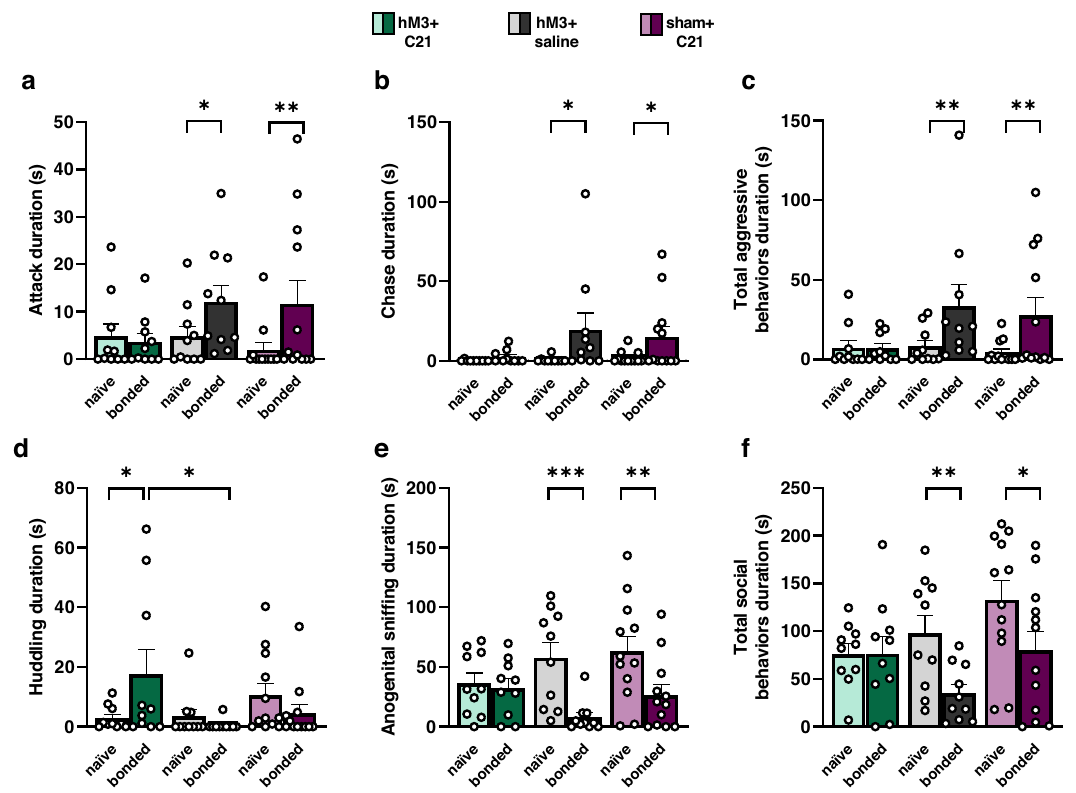
Fig. 4 LS activation reduces pair bond-induced aggression and promotes prosocial behaviors. Duration (s, seconds) of attacks ( a ), chasing ( b ), total aggressive behaviors ( c , sum of the duration of attack, chase, and pounce behaviors), huddling ( d ), anogenital snif fi ng ( e ), and total social behaviors ( f , sum of the duration of huddling, anogenital snif fi ng, fl ank snif fi ng, and nose-to-nose snif fi ng behaviors) directed at the intruder by the resident hM3 + C21 (green bars), hM3 + saline (gray bars), and sham + C21 (purple bars) subjects when they are sex naïve (light color bars) and pair bonded (dark color bars) during the resident intruder test. Data are presented as mean ± SEM. Dots represent individual data for hM3 + C21 ( n = 10), hM3 + saline ( n = 10), and sham + C21 ( n = 12) subjects. * p < 0.05; ** p < 0.01; *** p < hM3 + saline males signi fi cantly decreased their latencies to attack in comparison to when they were sex naïve ( t 35.3 = − 4.18, p = 0.0002), showing the expected pattern of post-bond selective aggression 16,23 . The sham + C21 males also tended to decrease but this decrease ( t 35.3 = − 1.58, p = 0.12). In contrast, LS activation inhibited